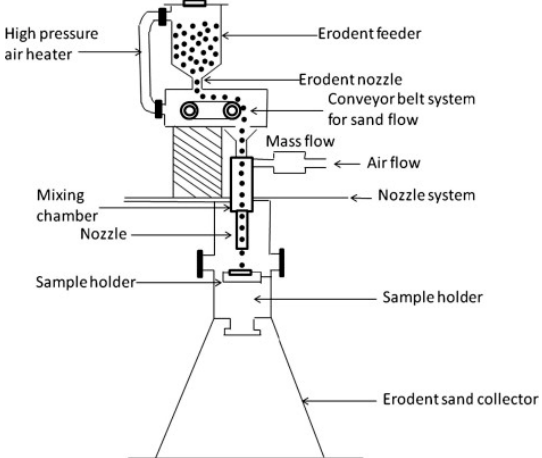
Figure 3. Scheme of the solid particle erosive test stand. Reprinted with permission from ref. [27]. Copyright 2010 Elsevier.